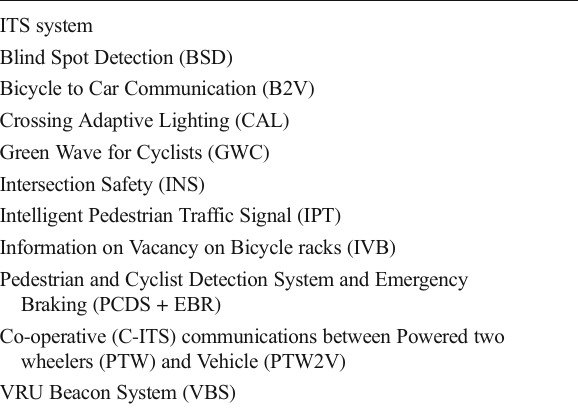
Overview 10 selected ITS systems ITS system Blind Spot Detection (BSD) Bicycle to Car Communication (B2V) Crossing Adaptive Lighting (CAL) Green Wave for Cyclists (GWC) Intersection Safety (INS) Intelligent Pedestrian Traffic Signal (IPT) Information on Vacancy on Bicycle racks (IVB) Pedestrian and Cyclist Detection System and Emergency Braking (PCDS + EBR) Co-operative (C-ITS) communications between Powered two wheelers (PTW) and Vehicle (PTW2V) VRU Beacon System